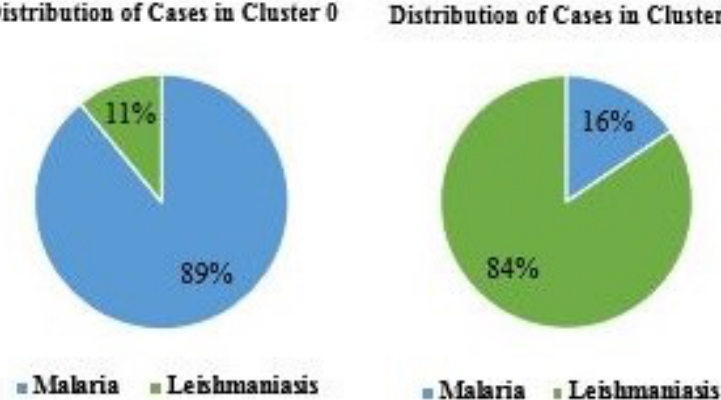
Figure 12. Proportion of Malaria and Leishmaniosis hospitalizations in the clusters 0 and 4 of state of Pará.